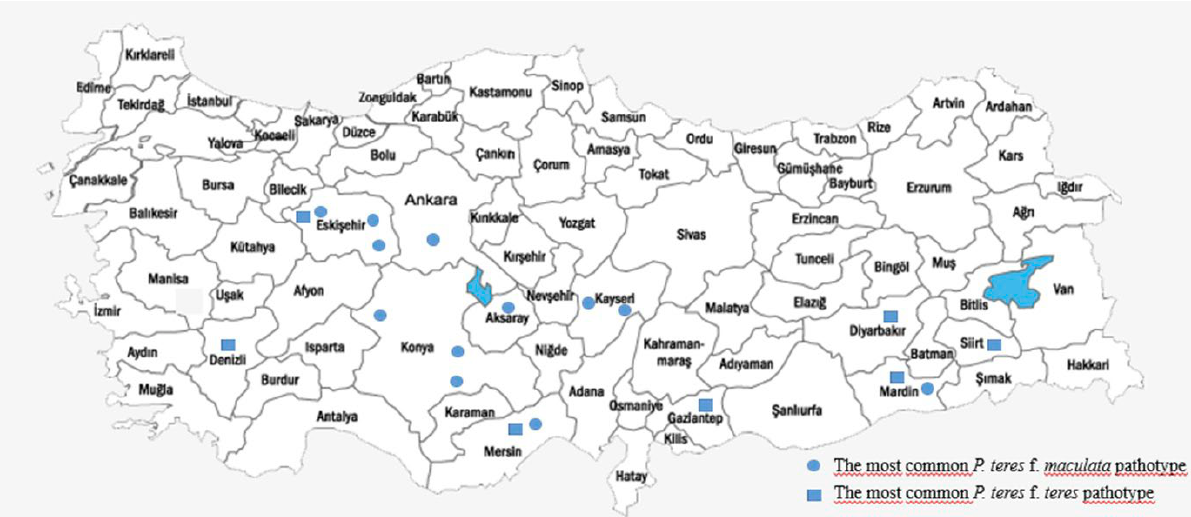
Figure 1. The locations of the most common Pyrenophora teres f . maculata and P. teres f . teres pathotypes in